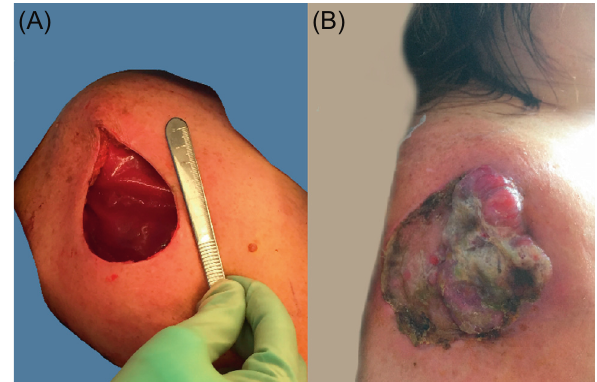
Figure 4. Liposarcoma of the right arm. (A) Wound after excision. (B) Recurrence a few weeks later. The majority of the already healed skin graft is damaged by the recurrent growth.